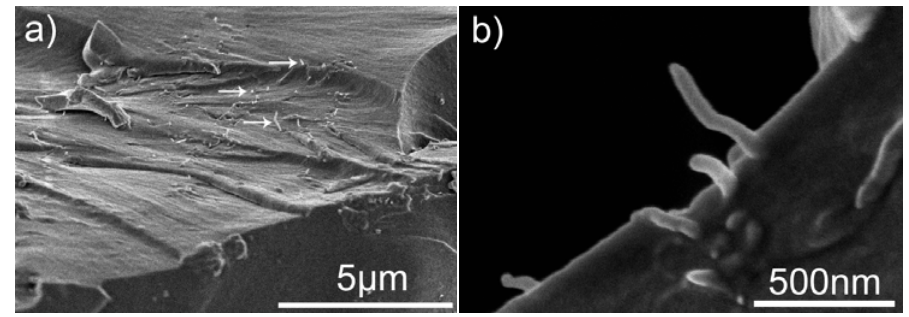
Figure 7. SEM images of fracture surface of epoxy composite reinforced by plasma nanocoated 10–30 nm diameter MWCNTs at ( a ) 10k× and ( b ) 80k×